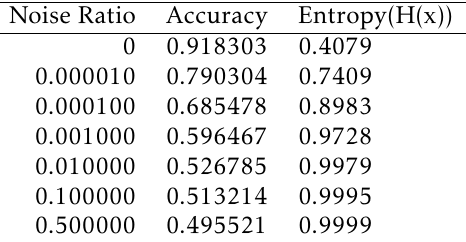
Table 5. Entropy and Noise Ratio